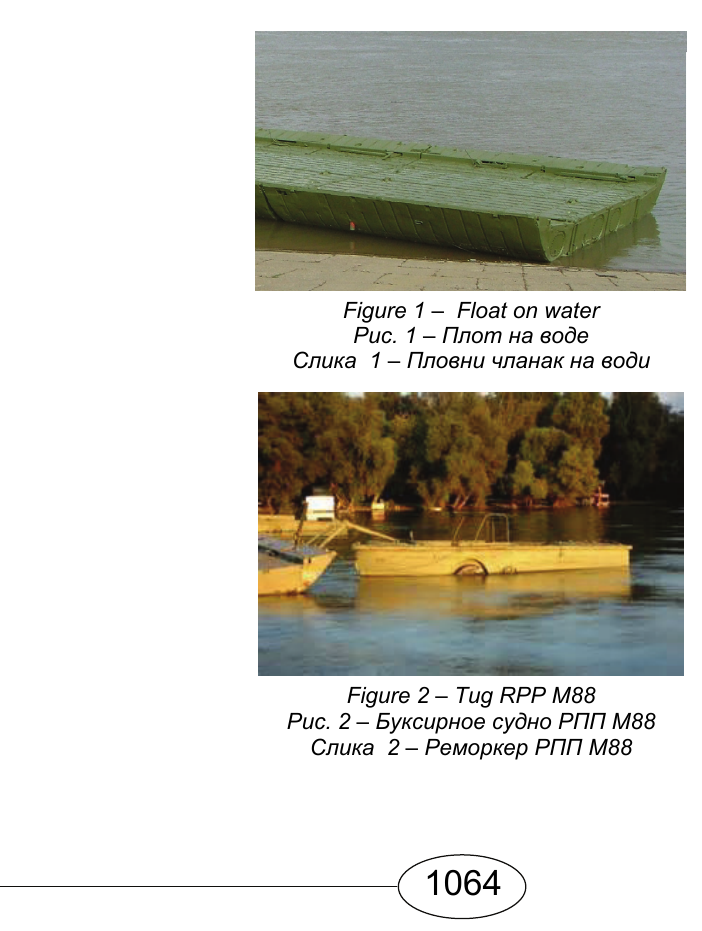
Figure 1 – Float on water Рис . 1 – Плот на воде Слика 1 – Пловни чланак на води